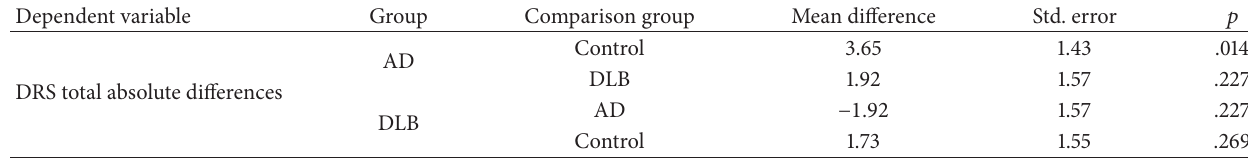
Table 6: Post hoc group comparisons (i.e., control, DLB, and AD) on measures of cognitive